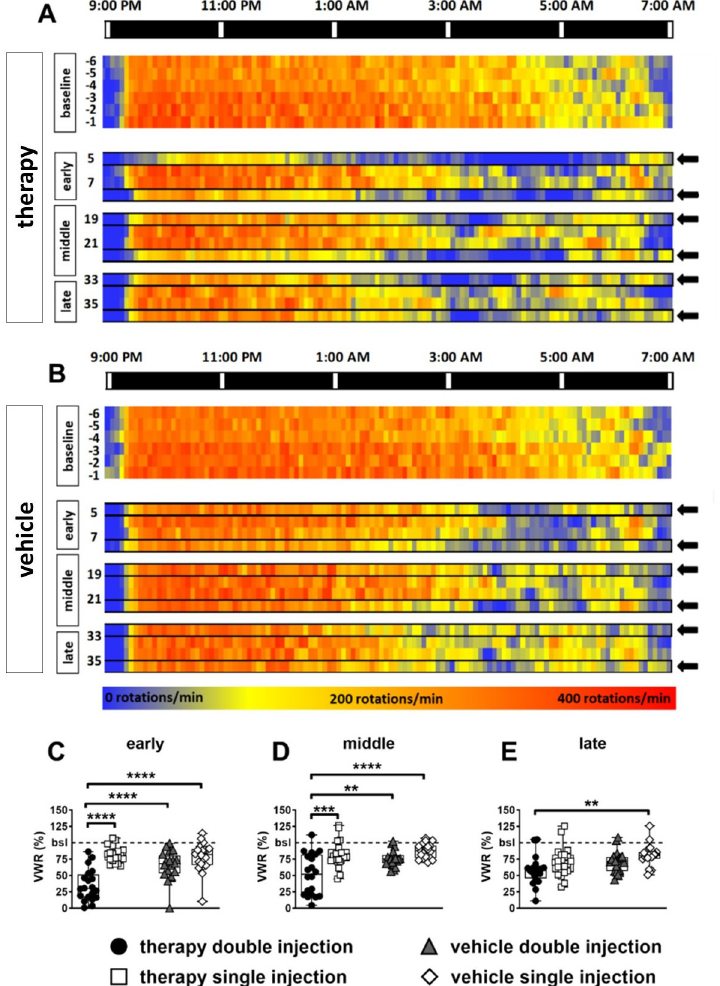
Fig 6. Assessment of VWR during chemotherapy and respective vehicle application. Heat map of VWR activity data displayed in 5-minute intervals during night-time for days of baseline (day -6 to -1) and three representative time periods (early day 5 to 8, middle day 19 to 22, late day 32 to 36), shown separately for the therapy group (6A) and the vehicle group (6B). The arrows indicate the days of double injection. Statistical analysis of the three time periods: (C) early period: RM two-way ANOVA: F (1, 76) = 41.46, p < 0.0001 for injection-frequency-dependent variation; F (1, 76) = 8.567, p = 0.0156 for group-dependent variation;Tukey’s multiple comparisons test, p < 0.0001. (D) intermediate period: RM two-way ANOVA: F (1, 72) = 18.40, p < 0.0001 for injection-frequency-dependent variation, F (1, 72) = 10.19, p = 0.0021 for group-dependent variation; Tukey’s multiple comparisons test, p < 0.01. (E); late period: RM two-way ANOVA: F (1, 72) = 5.889, p = 0.0177 for injection-frequency-, F (1, 72) = 5.795, p = 0.0186 for group- dependent variation; Tukey’s multiple comparisons test, p < 0.01). � = p < 0.05, �� = p < 0.01, ��� = p < 0.001, ���� = p < 0.0001; bsl =